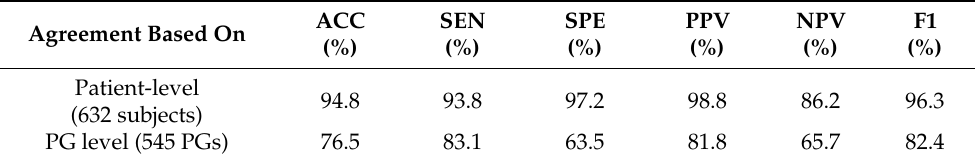
Table 4. Agreement with the experts after the inspection of the suggested areas. The agreement rating is reflected in the accuracy score. ACC: Accuracy, SEN: Sensitivity, SPE: Specificity, PPV: Positive Predictive Value, NPV: Negative Predictive Value, F1: F1